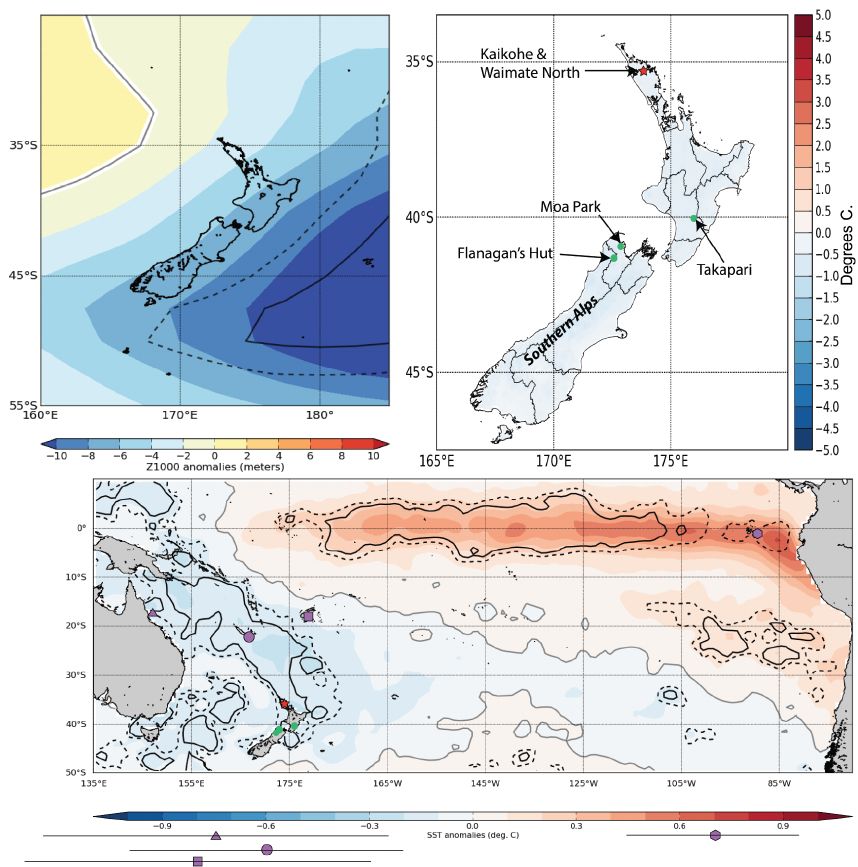
Figure 9. Top left: June–August (JJA) geopotential height anomaly at 1000hPa ( z 1000) over the New Zealand region for 1839–1851CE determined by an ensemble composite of reconstructions from three tree ring proxy sites (Moa Park, Takapari and Flanagan’s Hut) and the Reverend Richard Davis weather diary. Anomaly height is in metres. Reanalysis data are courtesy of the National Centers for Environmental Prediction (NCEP). Confidence intervals (90th and 95th) are noted with black (dashed and solid) contour lines. Top right: temperature anomalies for JJA as reconstructed using the selected analogue circulation patterns from four sites for 1839–1851CE. Temperature anomalies are degrees Celsius. Bottom: JJA sea surface temperature (SST) anomaly over the southwest Pacific region for 1839–1851CE determined by an ensemble composite of reconstructions from four proxy sites. Temperature anomaly is in degrees Celcius. SST reanalysis data is courtesy of the Hadley Centre (HADSSTa v3). Confidence intervals (90th and 95th) are noted with black (dashed and solid) contour lines. Supporting temperature reconstructions for years corresponding to the New Zealand data and associated errors are shown as purple symbols on the map to denote locations of reconstructions and alongside the SSTa scale with associated 1 standard deviation errors. The SSTa reconstructions are based on coral Sr / Ca from the Great Barrier Reef (triangle), New Caledonia (circle) and Fiji (square) in Delong et al. (2012) and from d18O for the equatorial Pacific at the Galapagos Islands (hexagon) after Dunbar et al. (1994). Base figures were generated using the Past Interpretation of Climate Tool (PICT) courtesy of National Institute of Water and Atmospheric Research (NIWA). See Lorrey (2014) and http://pict.niwa.co.nz for